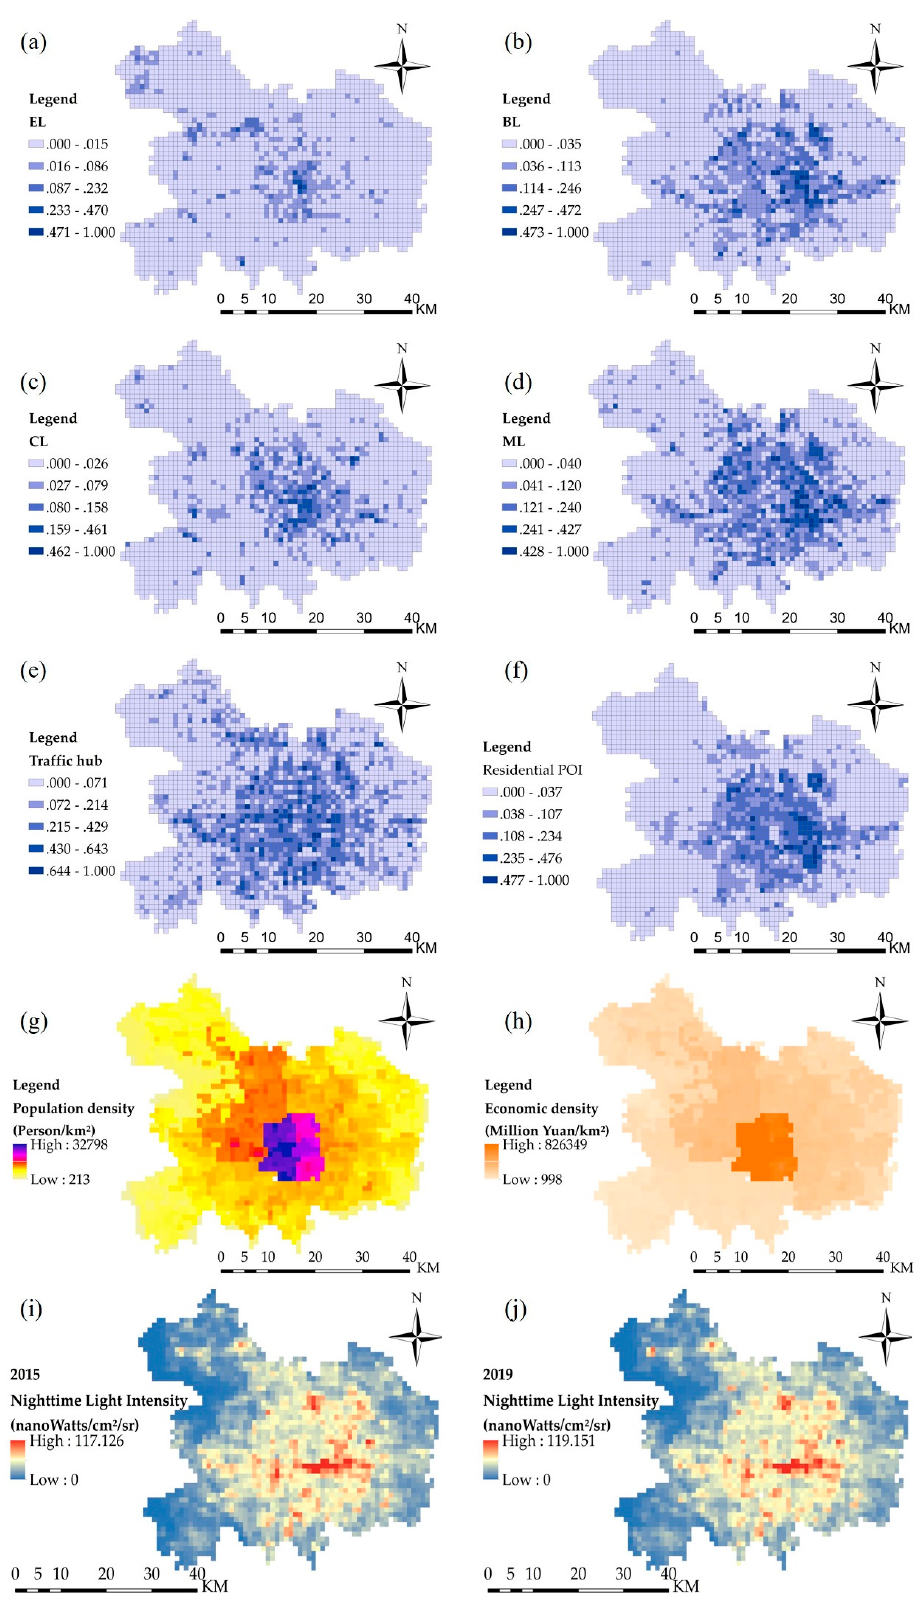
Figure 2. ( a – d ) Points of interest (POIs) of leisure services (LSs). ( e ) Traffic hubs. ( f ) Residential POIs. ( g ) Population density. ( h ) Economic density. ( i ) Nighttime light intensity in 2015. ( j ) Nighttime light intensity in 2019.